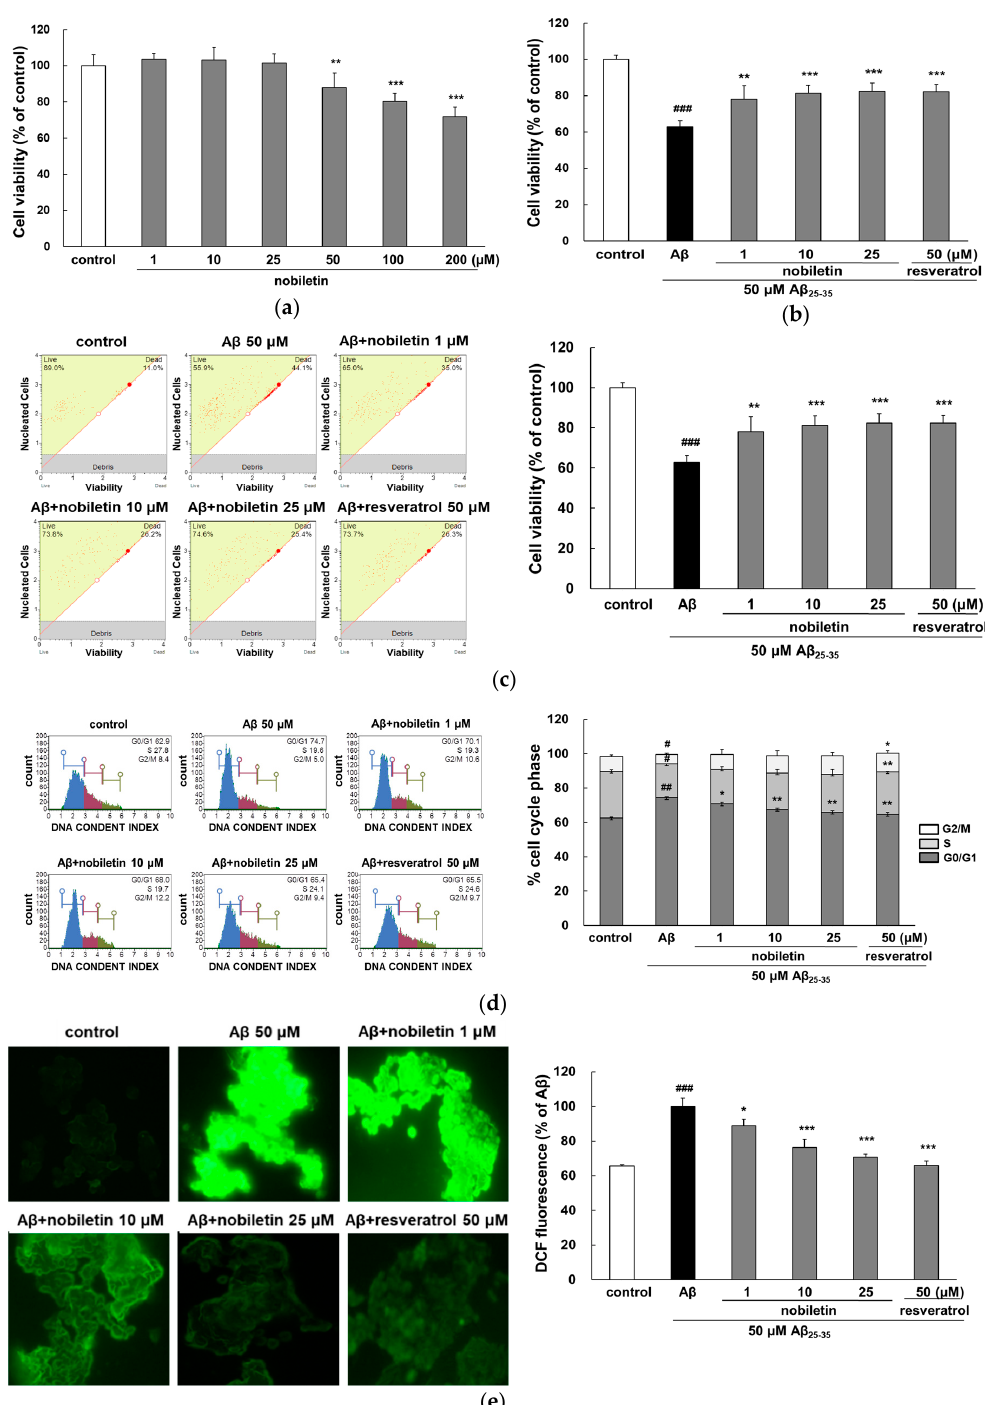
Figure 1. Protective properties of nobiletin against A β 25-35 -mediated cell damage. ( a ) Evaluation of cytotoxicity nobiletin alone in PC12 cells. Cells were pretreated with nobiletin for 1 h followed by exposure to 50 μ M of A β 25–35 for 24 h, and cell viability was assessed by ( b ) MTT reduction assay and ( c ) fluorescence-activated cell sorting (FACS) analysis. ( d ) Cell cycle progression was measured by FACS. The percentage of cells in the G 0 / G 0 , S, and G 0 / M phases of the cell cycle was determined using the Muse 1.5 Analysis software. ( e ) Intracellular ROS production was observed by CM-H 2 DCFDA fluorescent dye. ### p < 0.001, ## p < 0.01, and # p < 0.05 vs. control. *** p < 0.001, ** p < 0.01, and * p < 0.05 vs. A β 25–35